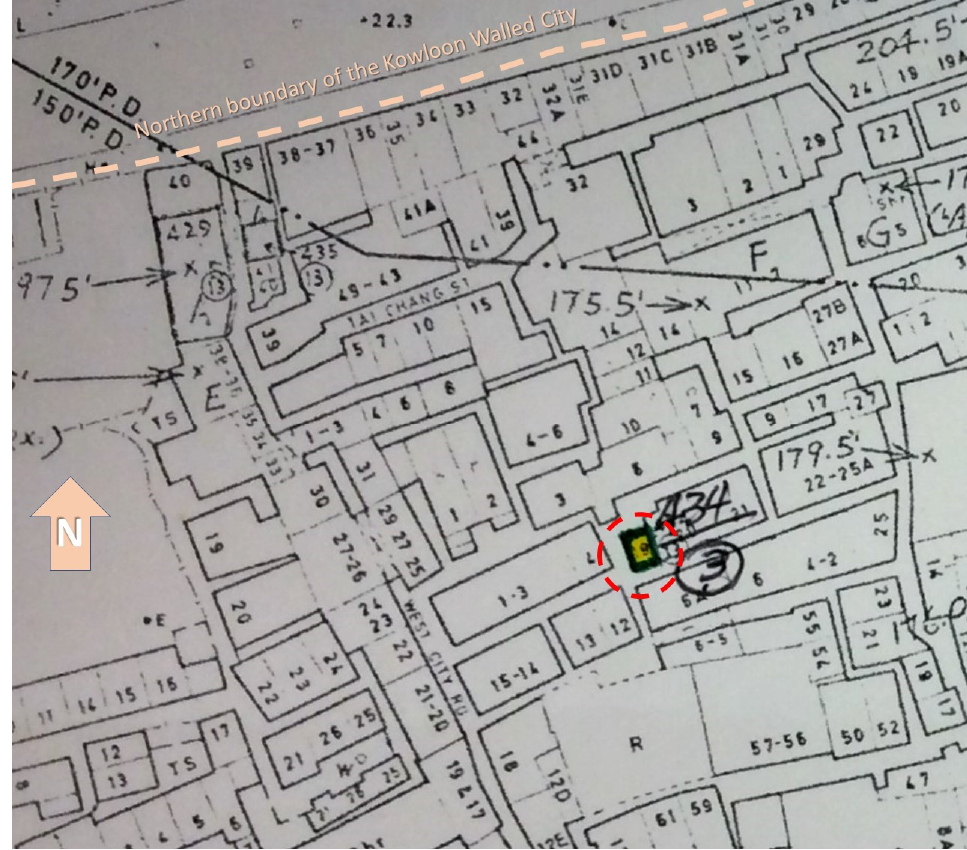
Figure 5. No.19 Shung Yee Lane (highlighted in the red broken-line circle) on a 1975 report map.